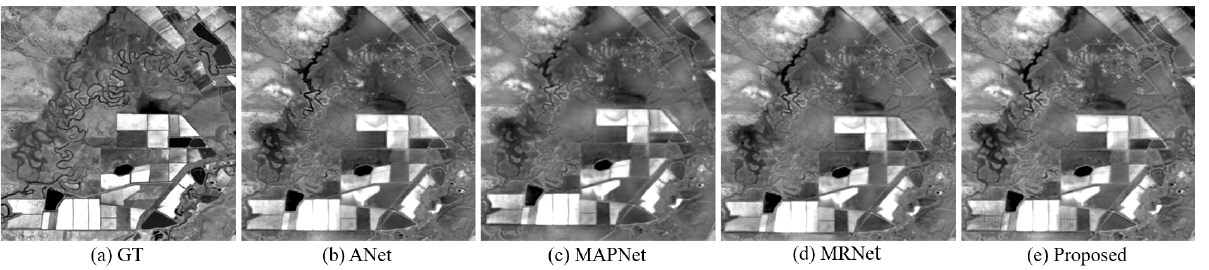
Figure 11. The results on the LGC dataset of these comparative experimental